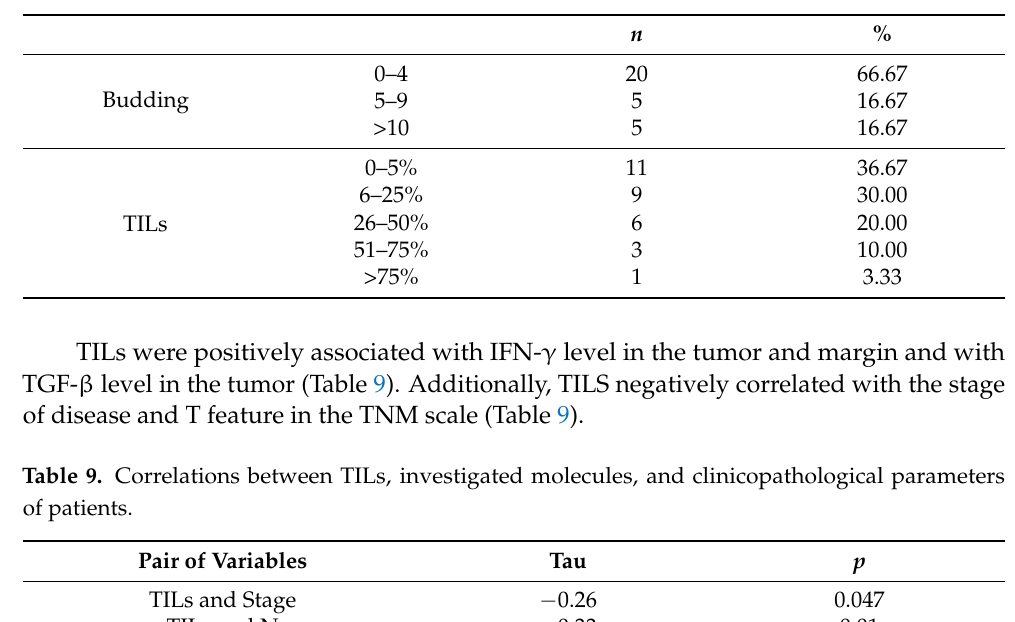
Table 8. Budding and TILs assessment in investigated specimens.